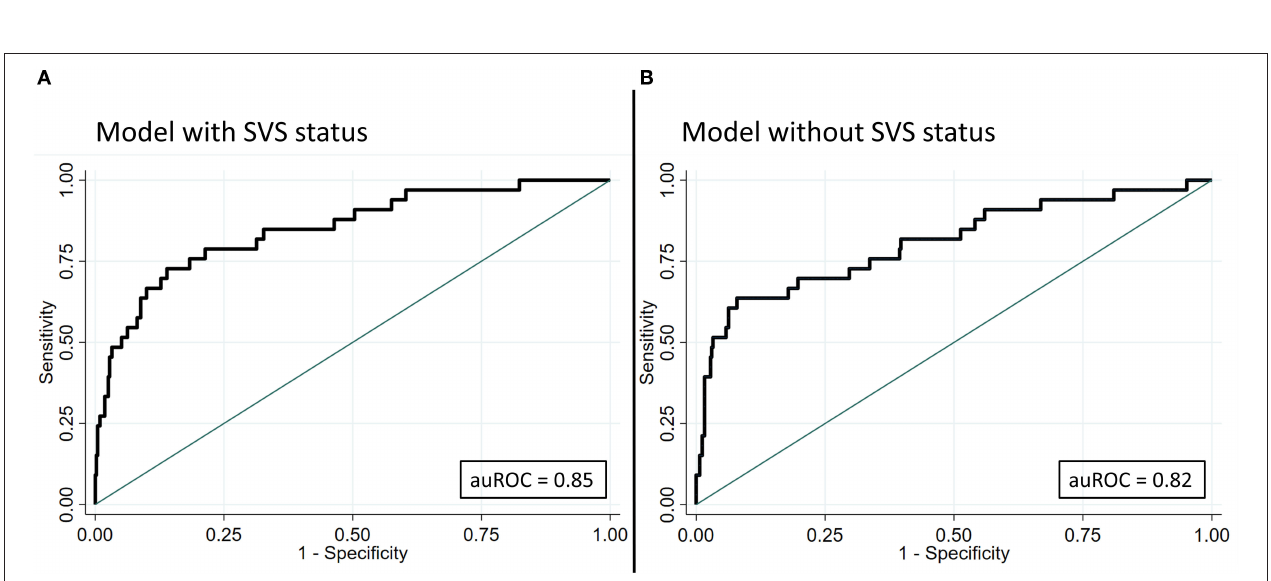
FIGURE 3 | Comparison of predictive models for active malignancy with and without SVS status. The covariables used for the predictive models were age at admission and gender and variables associated with active malignancy in the multivariable logistic regression (ESUS, multiterritory infarcts, D-dimer, Hb, leukocytes). The auROC of the model with SVS status was 0.85 (95% CI 0.78–0.92, A ). The internal cross-validation demonstrated no variation of the auROC and 95% CI. In the absence of the SVS status, the auROC of the model was 0.81 (95% CI 0.72–0.90, B ), the internal cross-validation showed an auROC of 0.82 (95% CI 0.68–0.90). The DeLong test did not show a significant difference between the two models ( p = 0.074). auROC, area under the receiver operating characteristics curve; CRP, C-reactive protein; ESUS, embolic stroke of undetermined source; Hb, hemoglobin; SVS, susceptibility vessel sign.